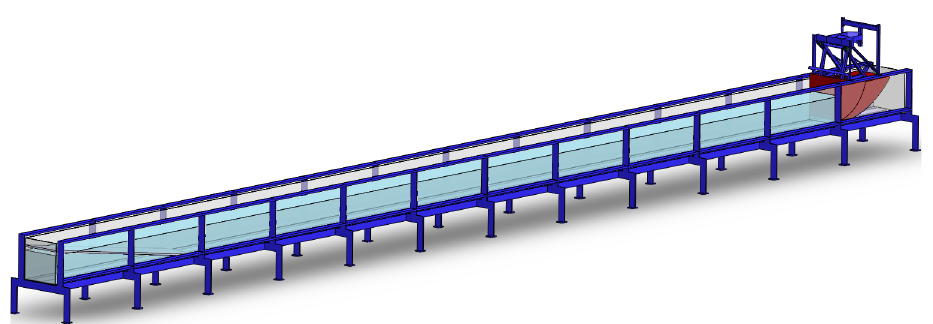
Figure 4. Wave flume setup and sketch, as installed at the University of